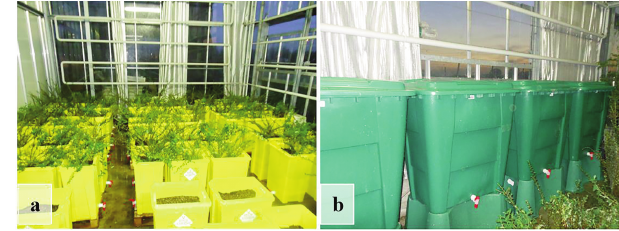
Fig. 2 ­ Photo of the greenhouse experiment at the University of Florence, Italy: (a) bioretention pot prototypes, (b) 200­L plastic water storage